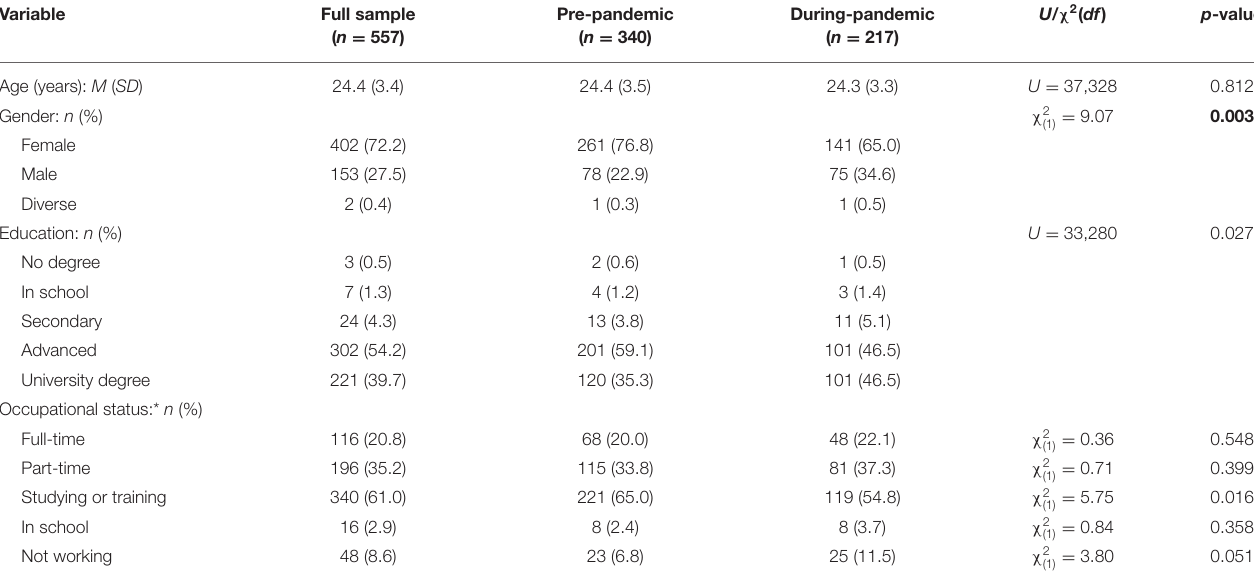
TABLE 1 | Sociodemographic